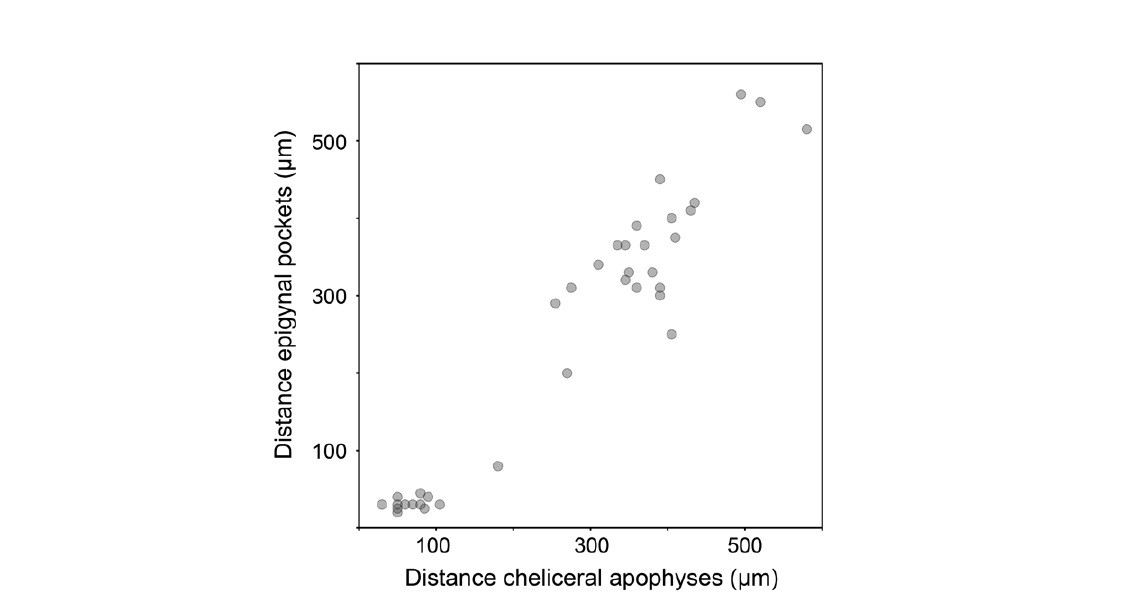
Fig. 866. Scatter diagram showing the correlation between the distances between the male cheliceral apophyses (tips) and the distances between the female epigynal pockets. Each dot represents one species (all known representatives of Holocnemus Simon, 1873, Maghreba gen. nov., and Crossopriza Simon,